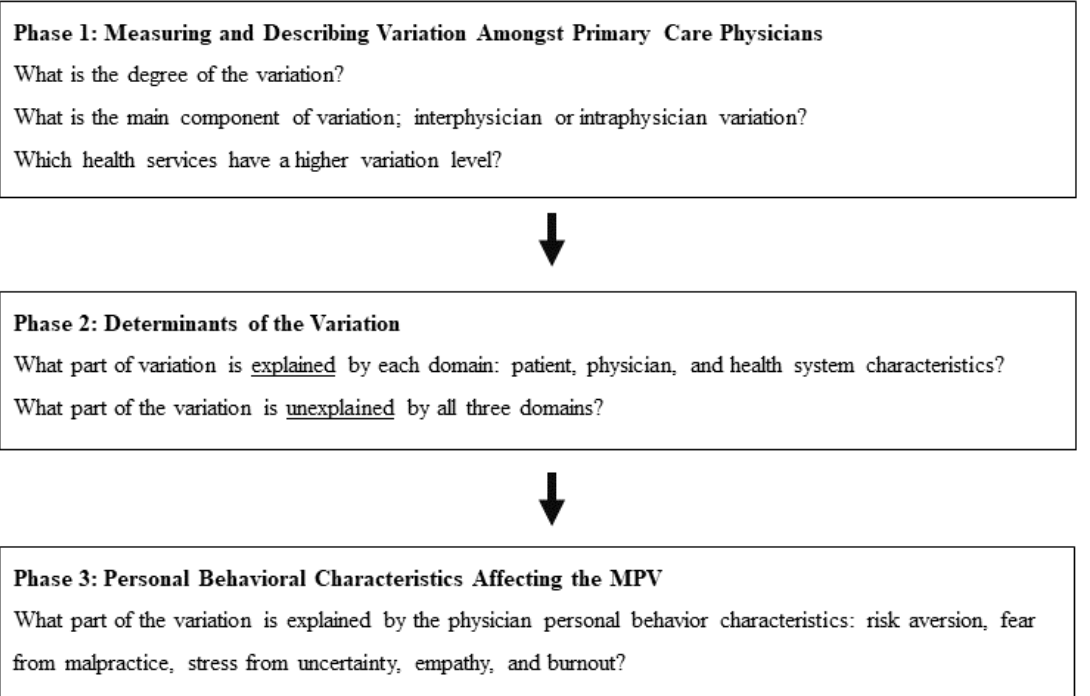
Figure 2. Study flowchart - medical practice variation